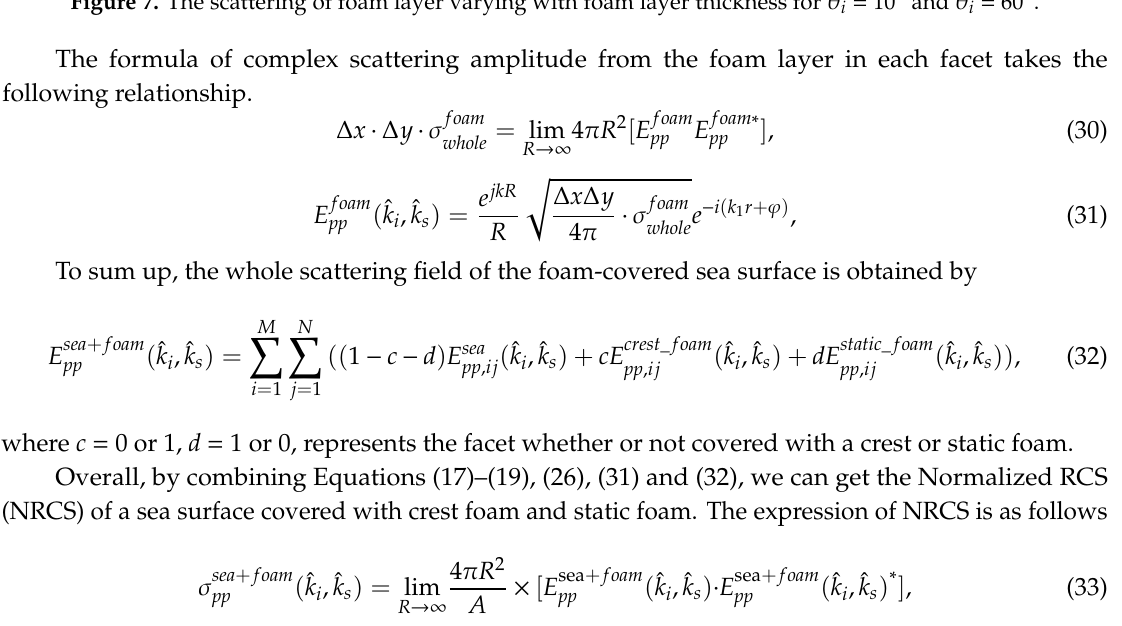
Figure 7. The scattering of foam layer varying with foam layer thickness for θ i =10° and θ i =60°.